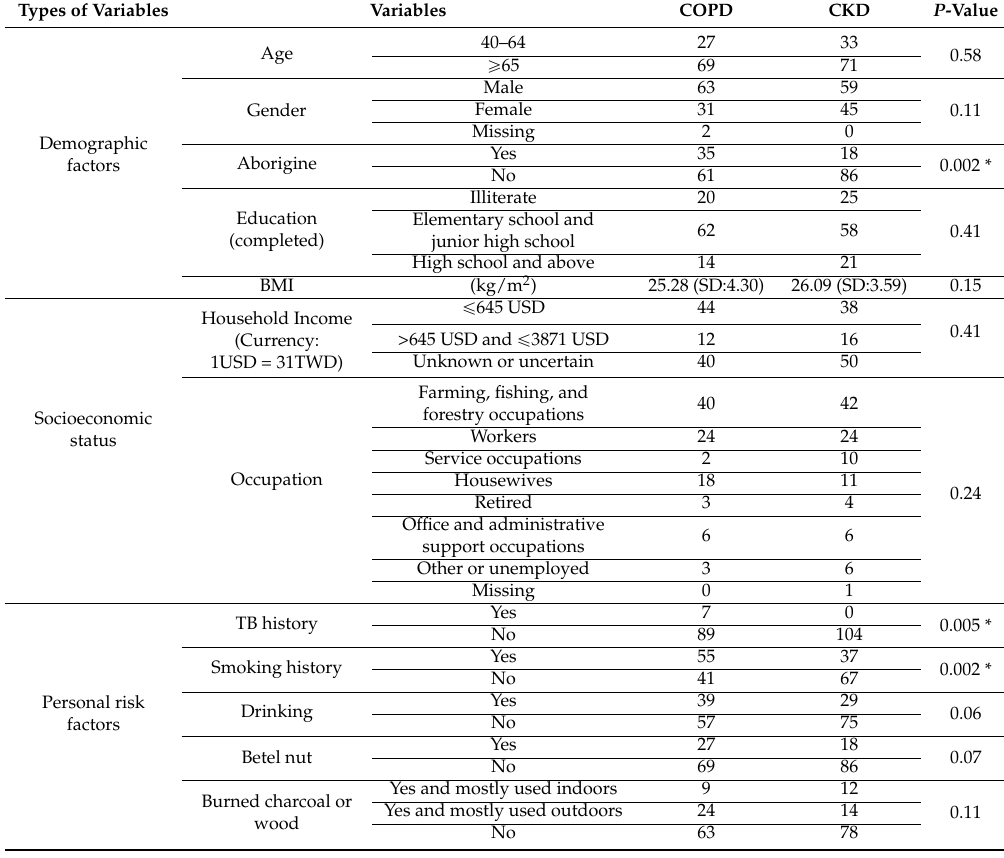
Figure 4. The spatial distribution of the patients in the case-control study ( A ) COPD; ( B ) CKD. Table 1. The differences of demographic variables and risk factors between COPD and CKD patients. Types of